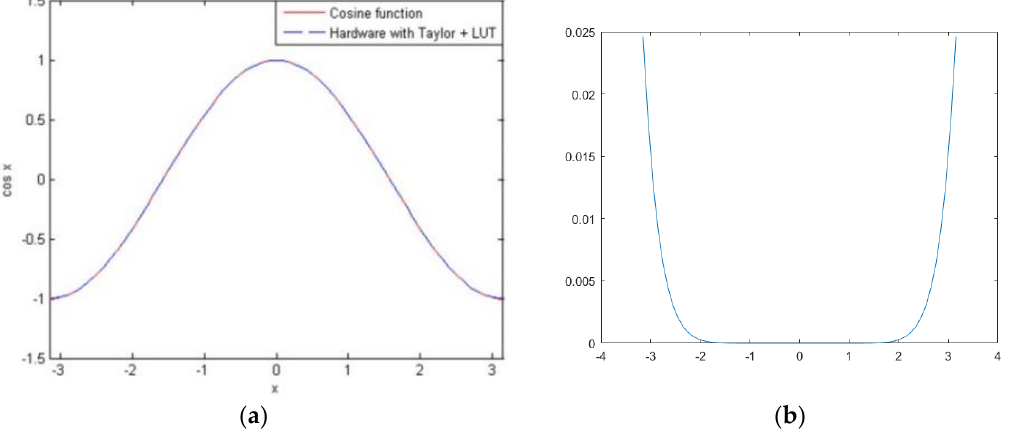
Figure 18. ( a ) Taylor and LUT approximation of the cosine function. ( b ) The error of the cosine